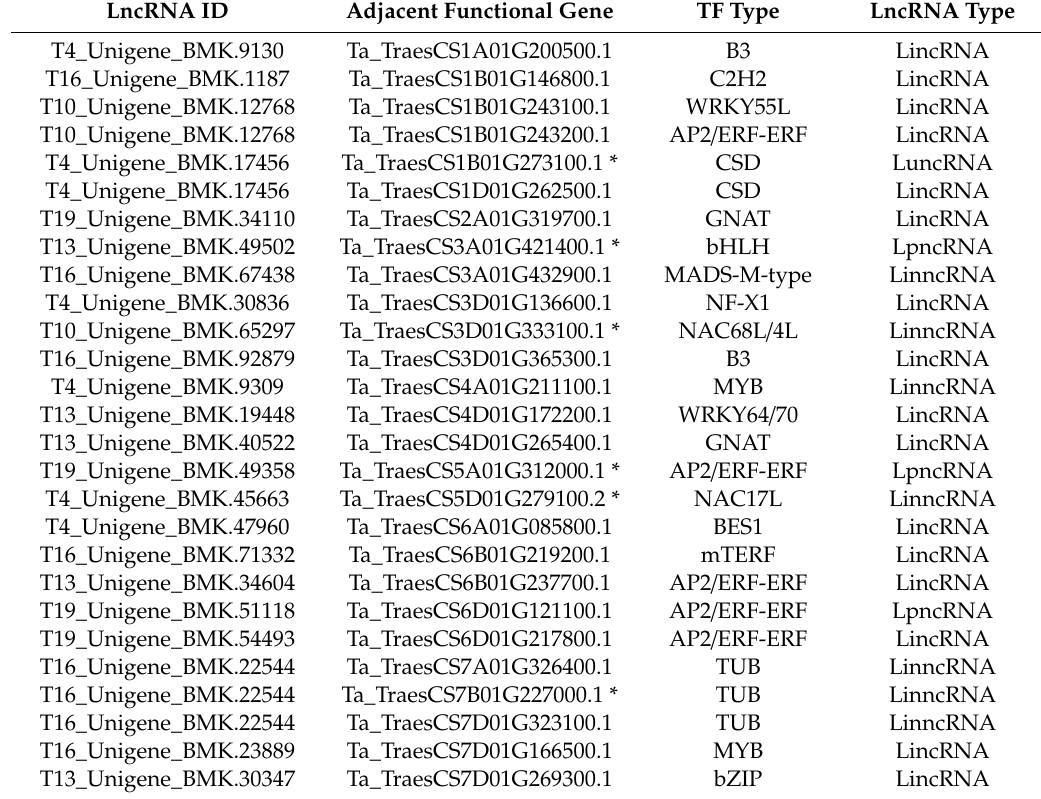
Table 1. The list of DE-lncRNAs with adjacent transcript